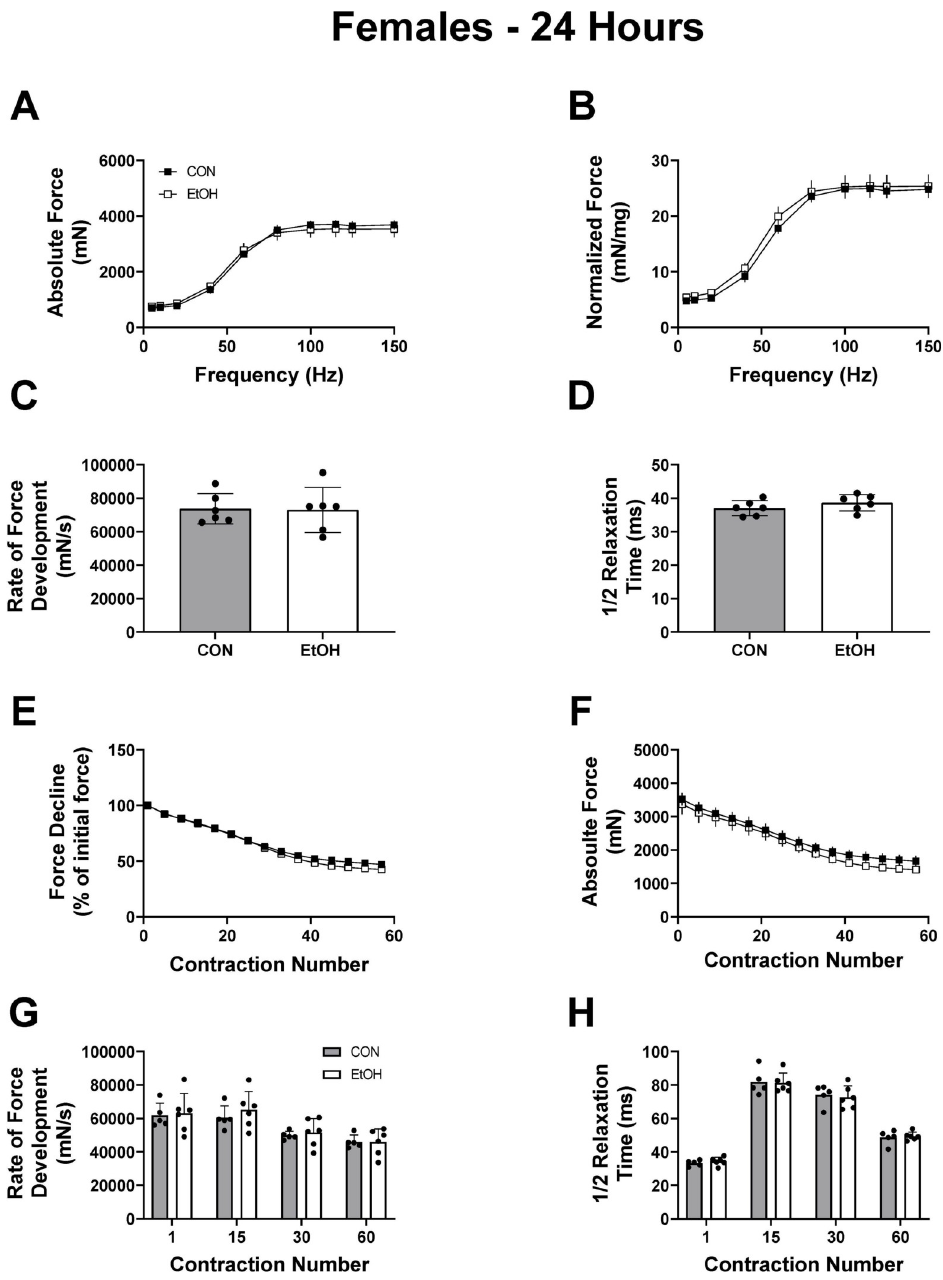
Fig 4. Recovery of muscle contractile properties and fatigue resistance in female mice 24 hours post alcohol intoxication. Outcomes of each contractile test at 24 hours post alcohol binge in female CON (n = 6) and EtOH (n = 6), mice. Panel A and B show absolute and normalized force over a range of frequencies, and Panel C and D show the rate of force development and ½ relaxation time at 125Hz. Panel E and F show the force decline either relative to the first stimulation (E) or in absolute terms (F). The rate of force development at a given contraction number during the fatigue protocol is shown in (G), with the corresponding ½ relaxation time shown in (H). Data were analyzed using two-way ANOVA or unpaired t-tests and are presented as mean ± SEM for Figures A-B and E-F, and as mean ± SD for Figures C-D and